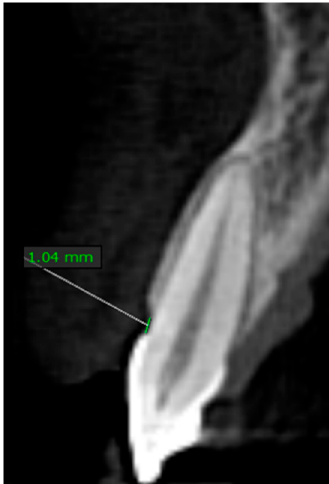
Figure 2. Distance from cementoenamel junction to facial bone crest as measured on cone beam computed tomography (CBCT).